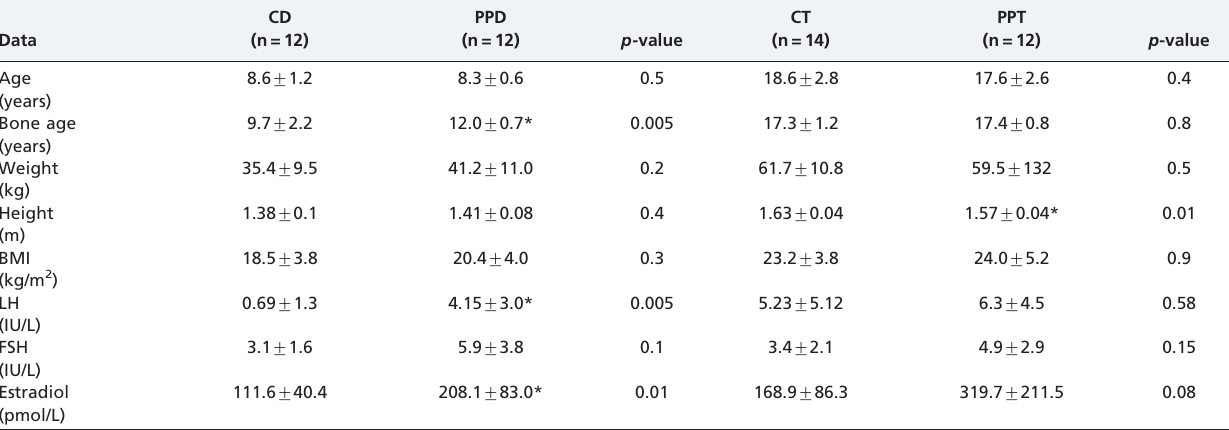
Table 1 - The clinical characteristics of control groups (CD and CT) and of patients with idiopathic central precocious puberty (iCPP) at diagnosis (PPD) and after treatment (PPT) with GnRHa.